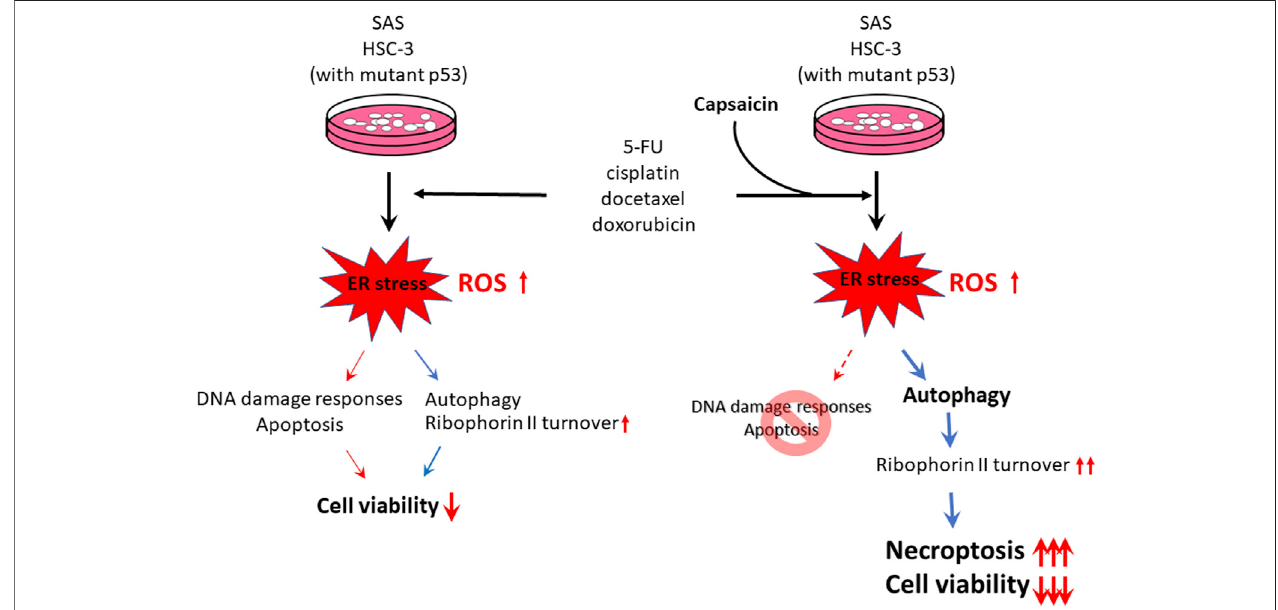
FIGURE 7 | Schematic representation of capsaicin inducing necroptosis when applied in combination with convenient anticancer drugs to HSC-3 and SAS cells. Our present results also suggest that autophagy-enhanced ribophorin II turnover might contribute to capsaicin-mediated cytotoxicity.